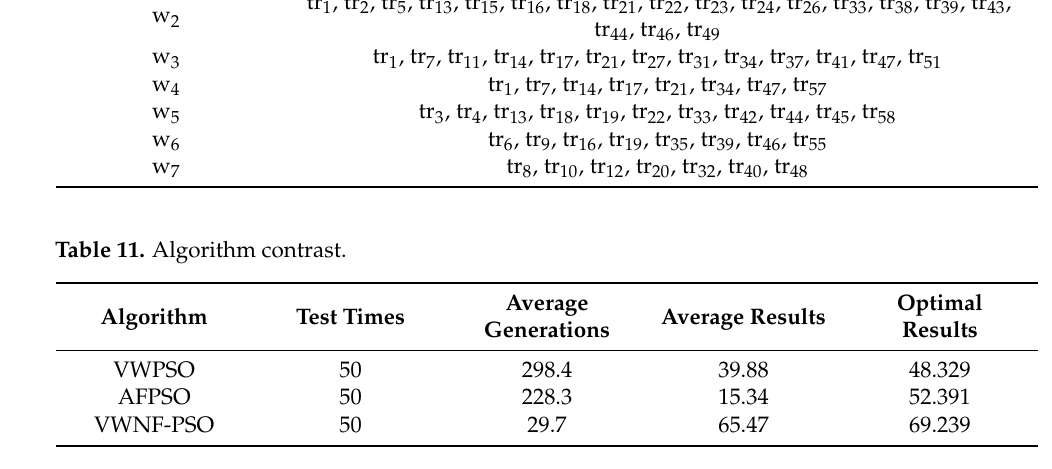
Table 12. Interceptor consumption.